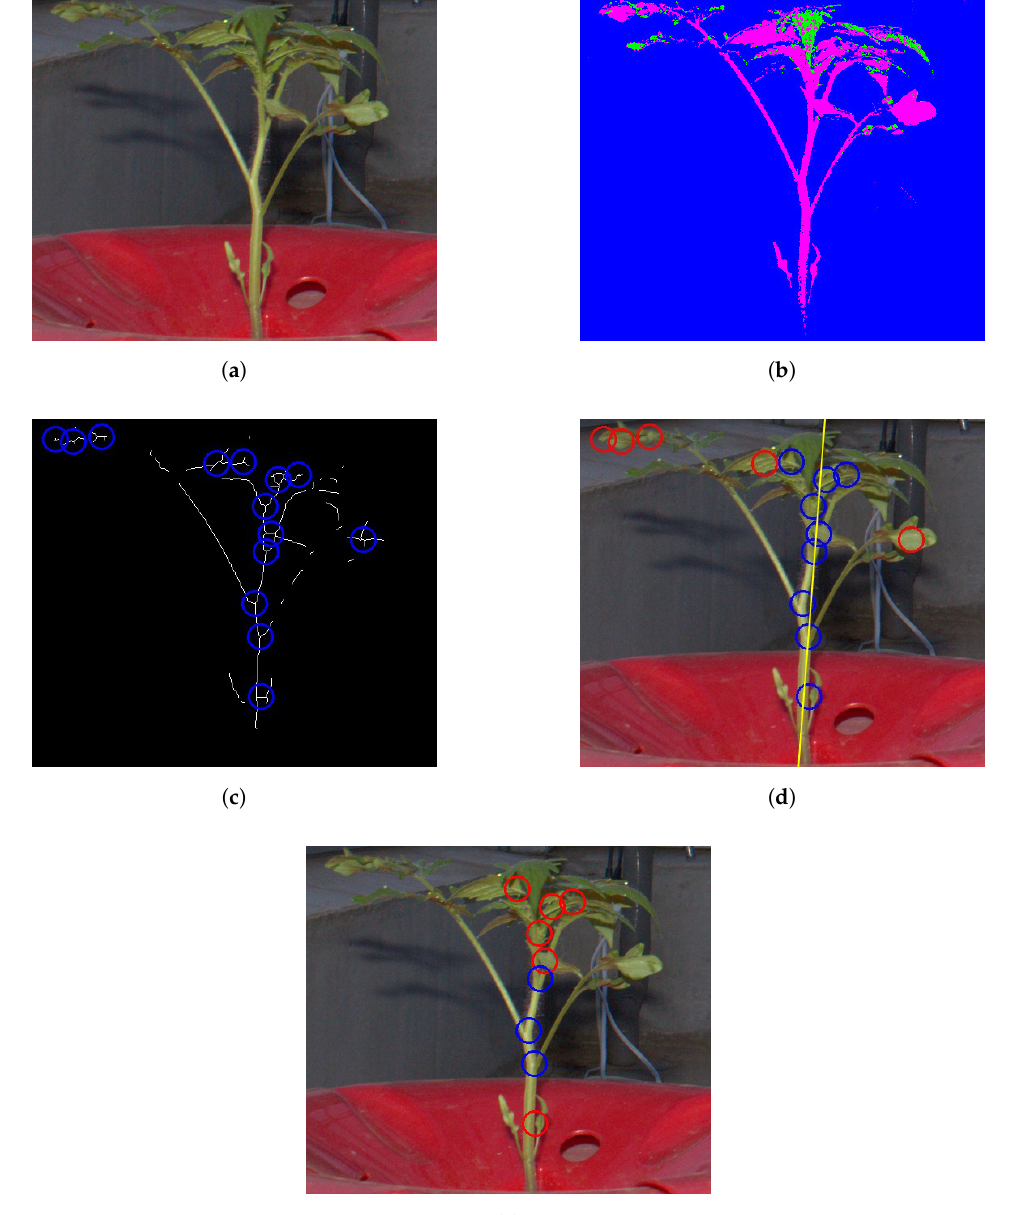
Figure 2. Example of node detection. ( a ) original image; ( b ) after pixel classification, where pixels drawn in green, purple, and blue were classified into leaf, stem, and background, respectively; ( c ) after thinning and branch point detection; ( d ) after main stem detection, where the yellow line represents the main stem line; ( e ) after Bag of Visual Words (BoVWs) application. In ( c – e ), the circle represents the candidate node pixels (blue: remaining candidate, red: removed